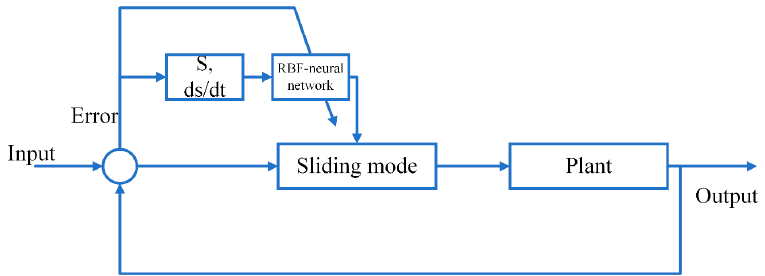
Figure 8. RBF neural network sliding mode controller .